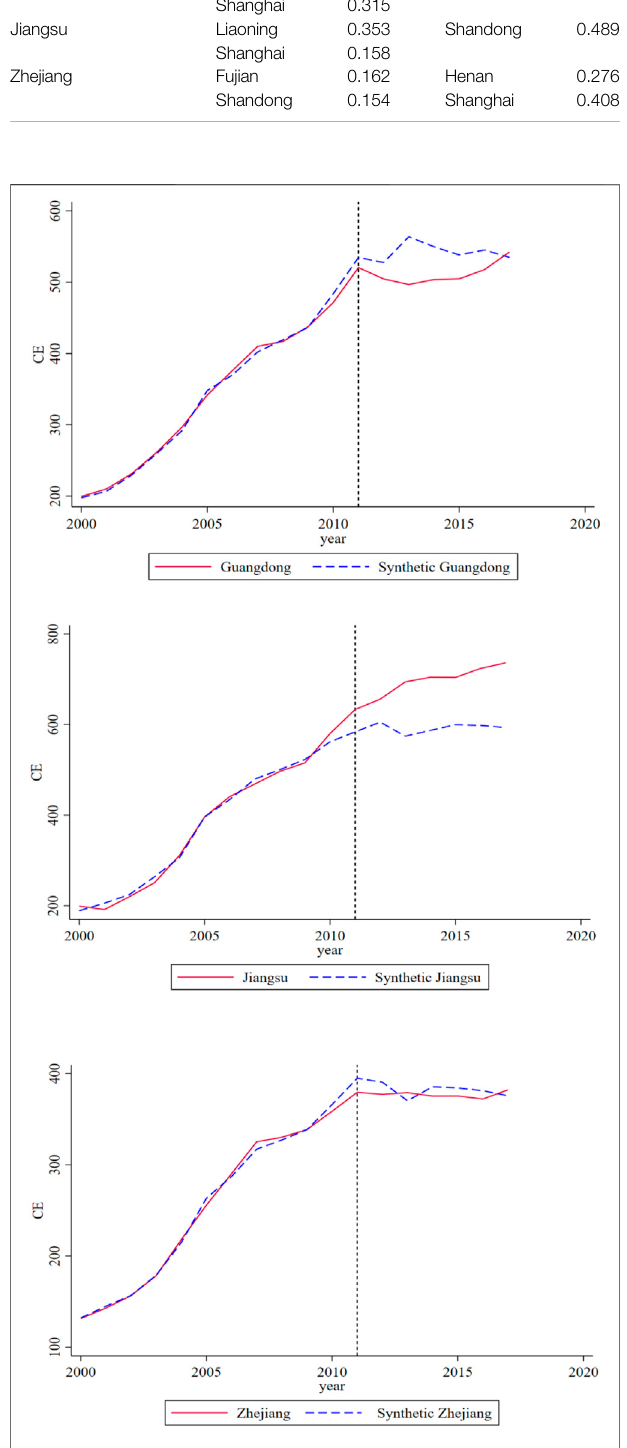
FIGURE 1 | Carbon emissions of experimental provinces and their syntheticcontrolobjects (fromtoptobottom: Guangdong,Jiangsu,Zhejiang).